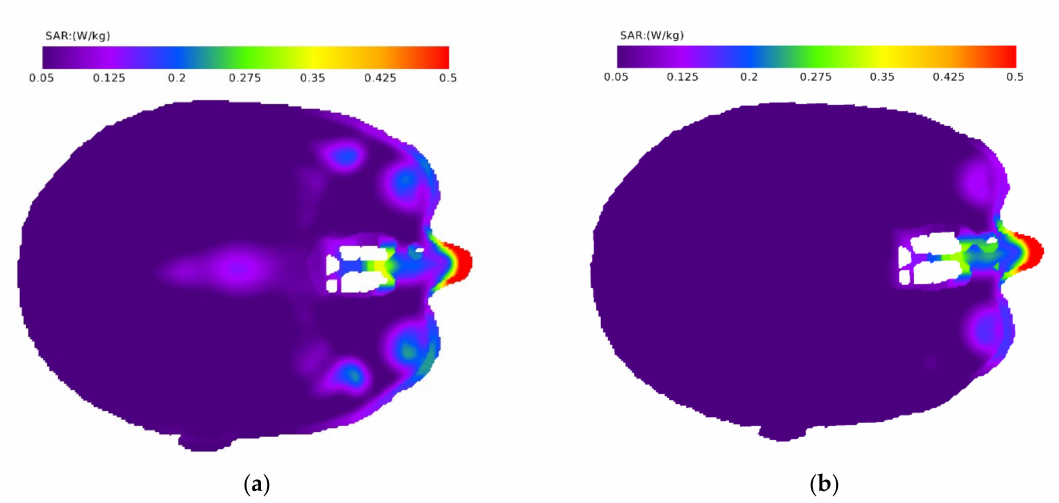
Figure 14. SAR averaged in 1 g of tissue mass simulated for 750 MHz: ( a ) no shield and ( b ) metal surface shield.